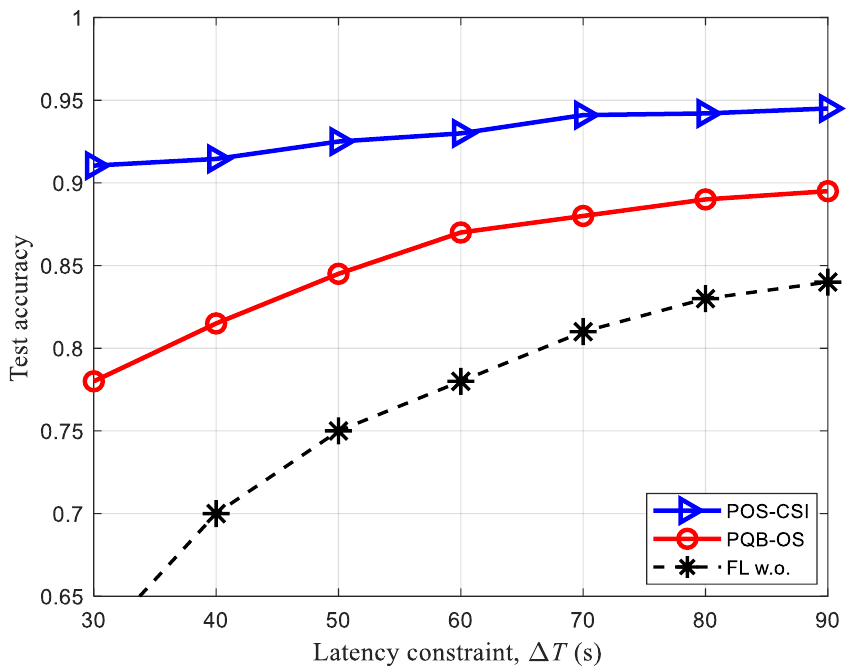
Figure 6. Test accuracy performance of different schemes with different latency constraint ∆ T with MNIST dataset for non-IID data distribution, when B n = 1 MHz, P n = 0.5 W, and D n =